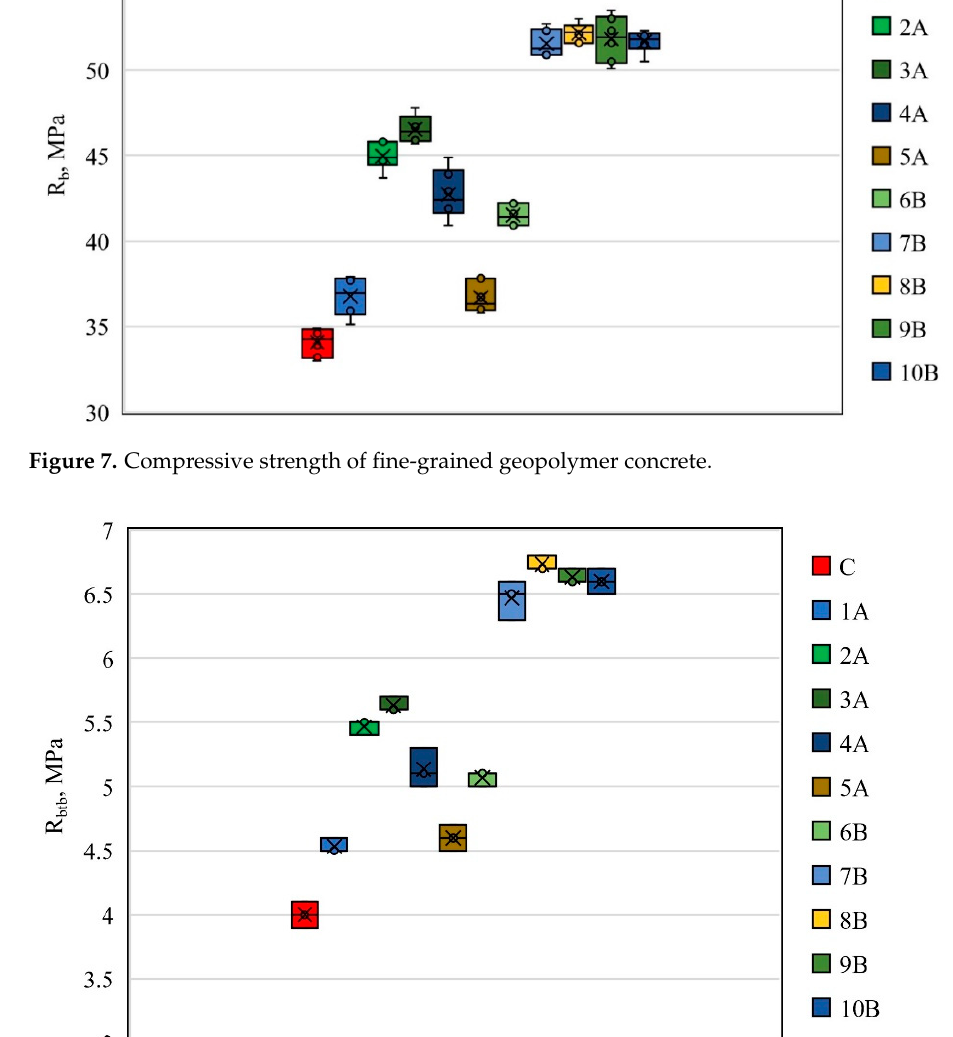
Table 10. Increases in strength characteristics of fine-grained geopolymer concrete depending on the dosage of micro calcite and potassium feldspar. Composition Title